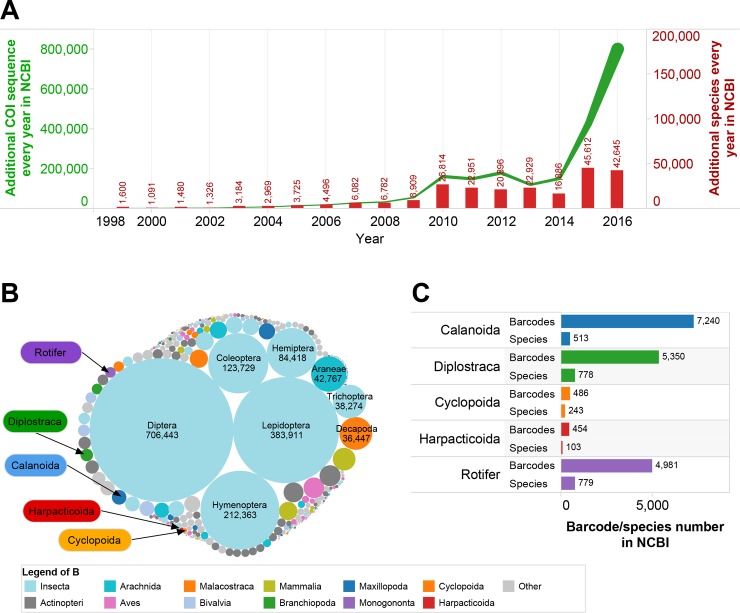
Composition of COI barcode sequence in NCBI Genbank.COI sequences were downloaded from NCBI Genbank with keyword “COI”. (A): Growth trend of COI sequences. (B): Taxa composition of COI sequences. (C): Composition of zooplankton COI sequences.